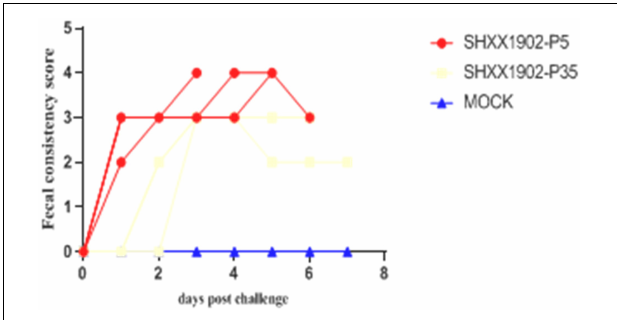
FIGURE 2 | Fecal consistency scores in piglets inoculated with PEDV SHXX1902-P5, SHXX1902-P35, or mock inoculated by 7 dpi. {0 = normal and no diarrhea [mean cycle threshold ( Ct ) values of > 45]; 1 = mild and fluidic feces; 2 = moderate watery diarrhea; 3 = severe watery and projectile diarrhea [mean Ct values of < 20]; and 4 = death}.